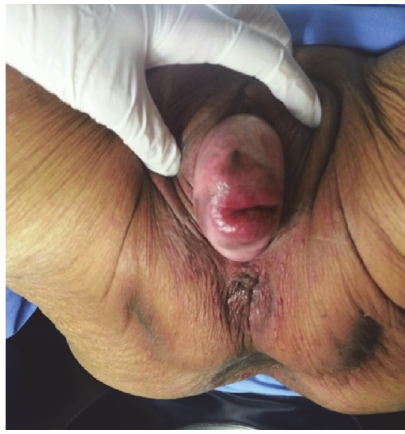
Figure 1: An 87-year-old woman with uterine prolapse Stage IV. adnexal mass. Rectal examination showed no abnormalities.